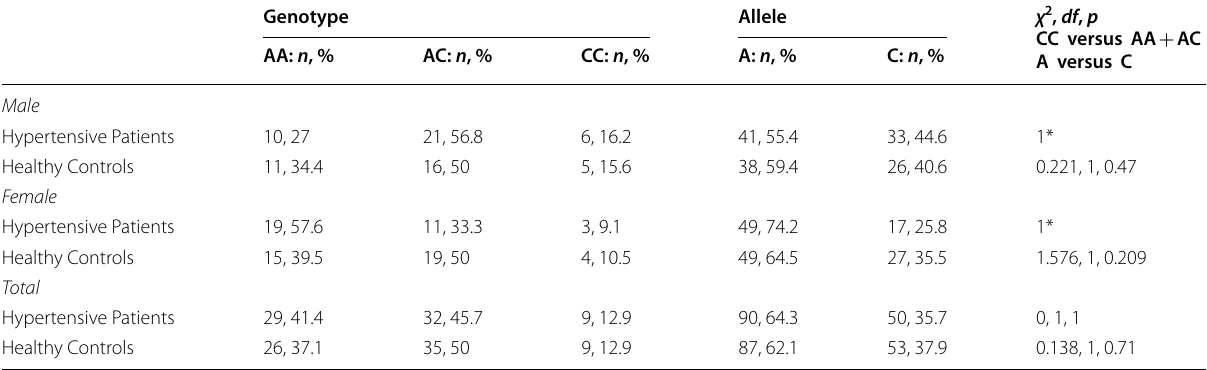
Table 2 Genotype and allele frequencies for the MTHFR A1298C (rs1801131) polymorphism among groups